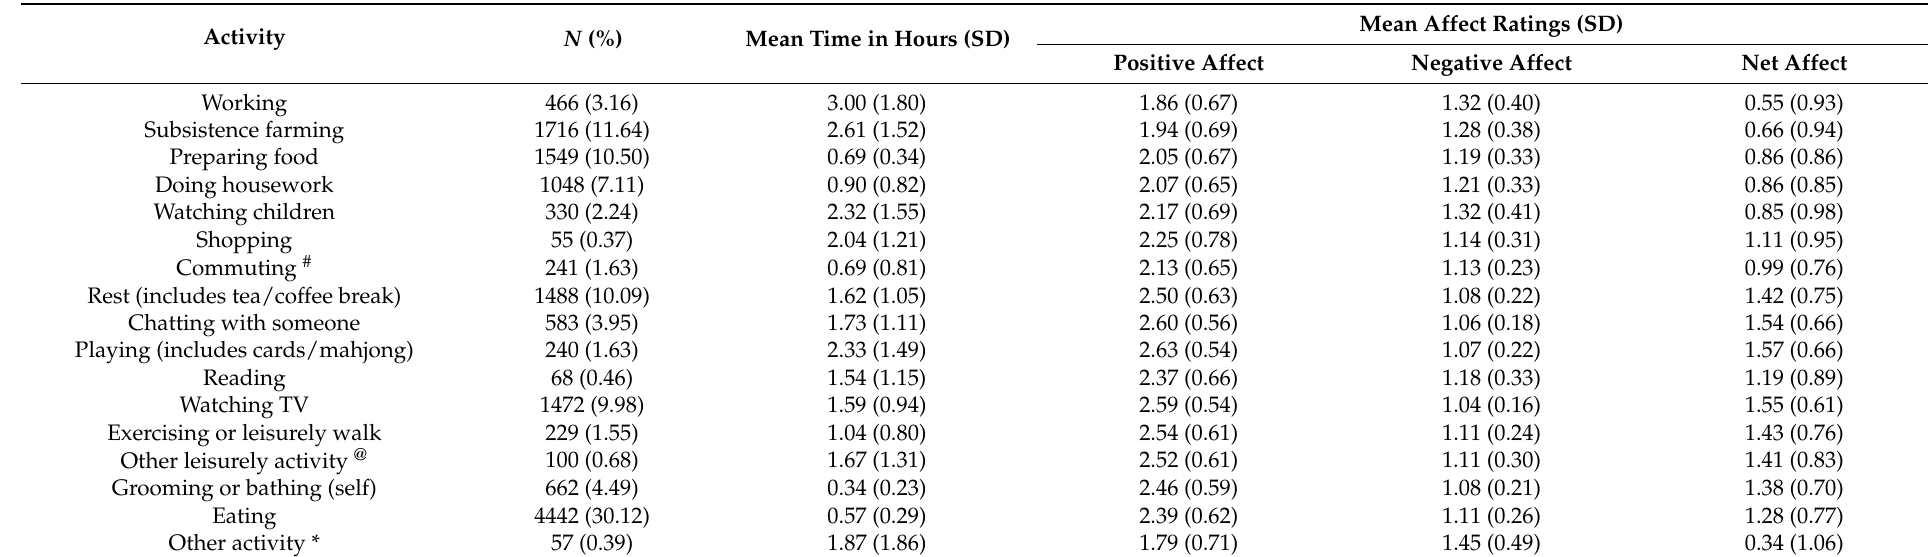
Table 2. Information of each type of activity and mean affect